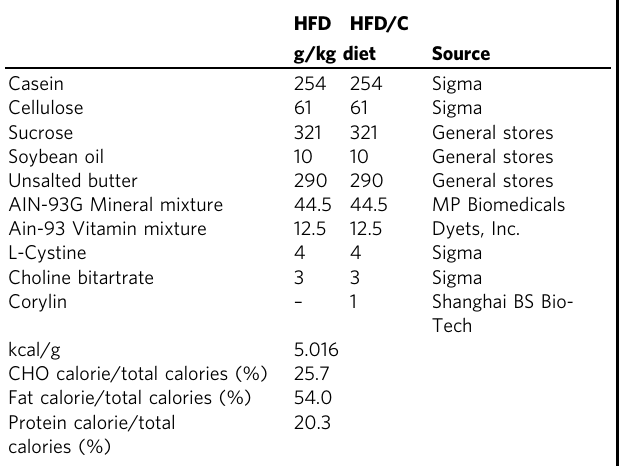
Table 3 Composition of the test